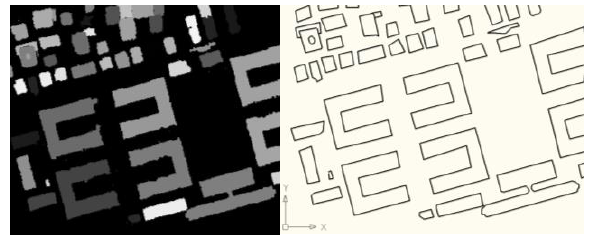
Figure 8. Original DSM, building footprints and generalized